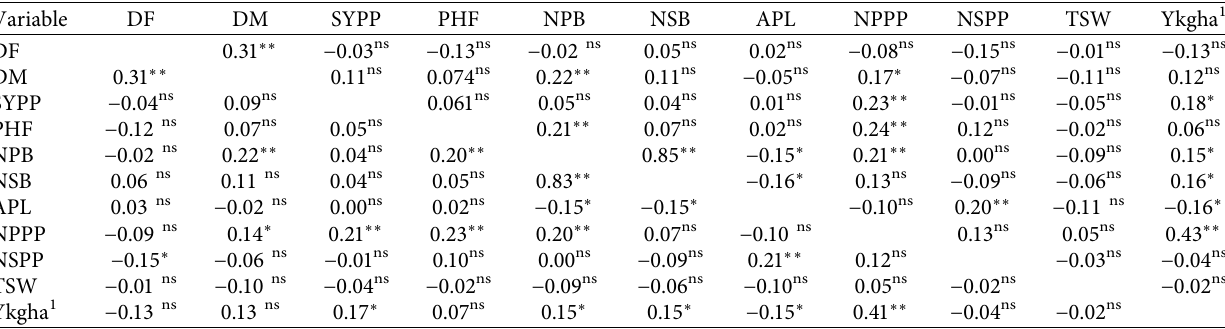
Table 4: Estimates of genotypic (above diagonal) and phenotypic (below diagonal) correlation coefcients among 11 traits studied in 160 fenugreek accessions. Variable